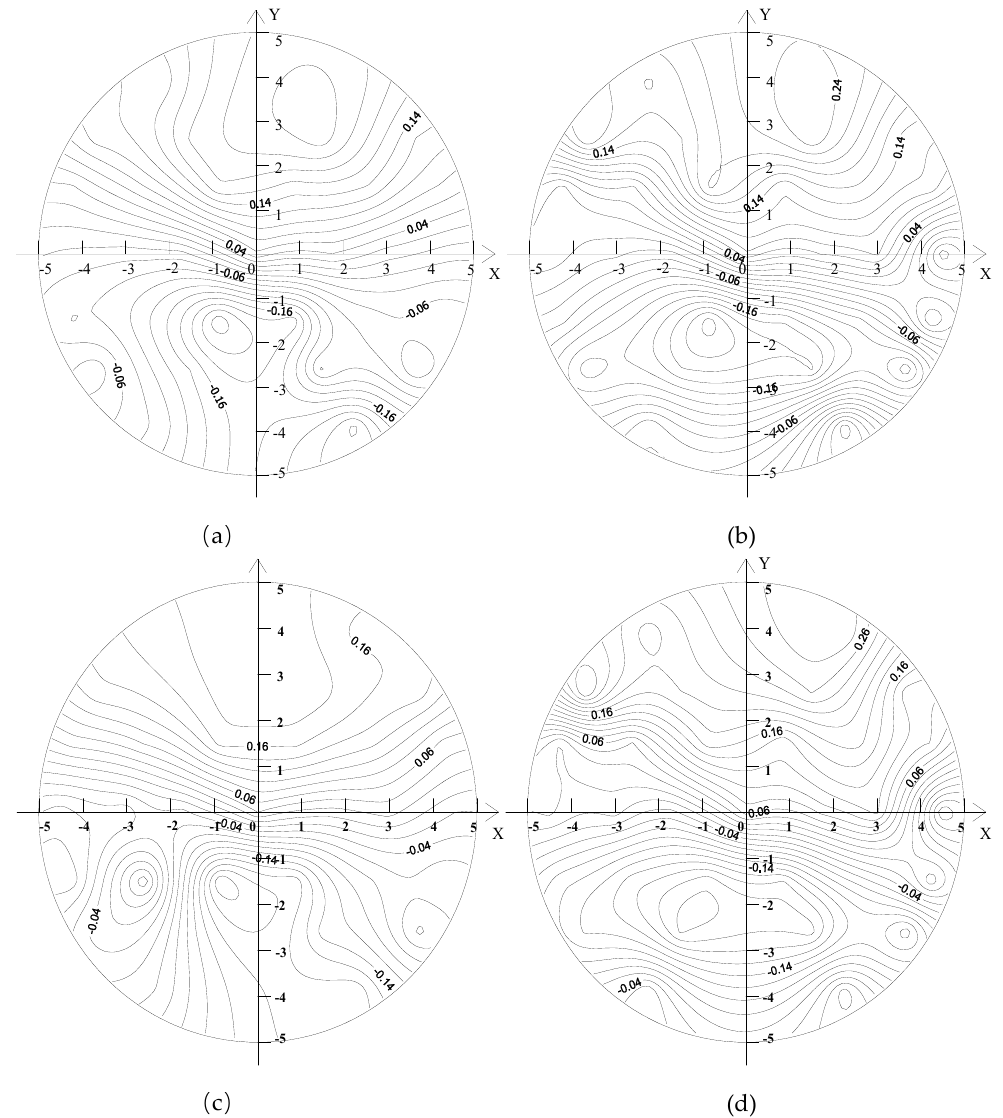
Figure 6. Circumferential velocity distributions of the upstream sections of capsules: ( a ) L / d = 2.5, Z = 3m; ( b ) L / d = 2.14, Z = 3m; ( c ) L/d = 2.5, Z = 0.1m; and ( d ) L / d = 2.14, Z = 0.1m.